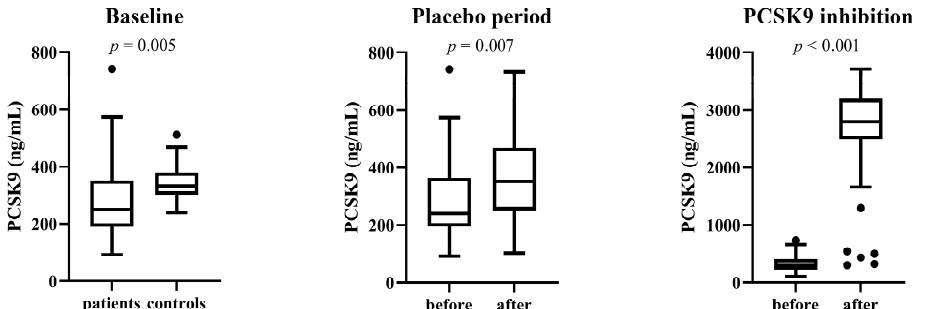
Figure 1. Serum PCSK9 levels in patients and control subjects at baseline, in patients before and after the placebo phase and before and after the 6-month period of therapy with PCSK9 inhibitors.